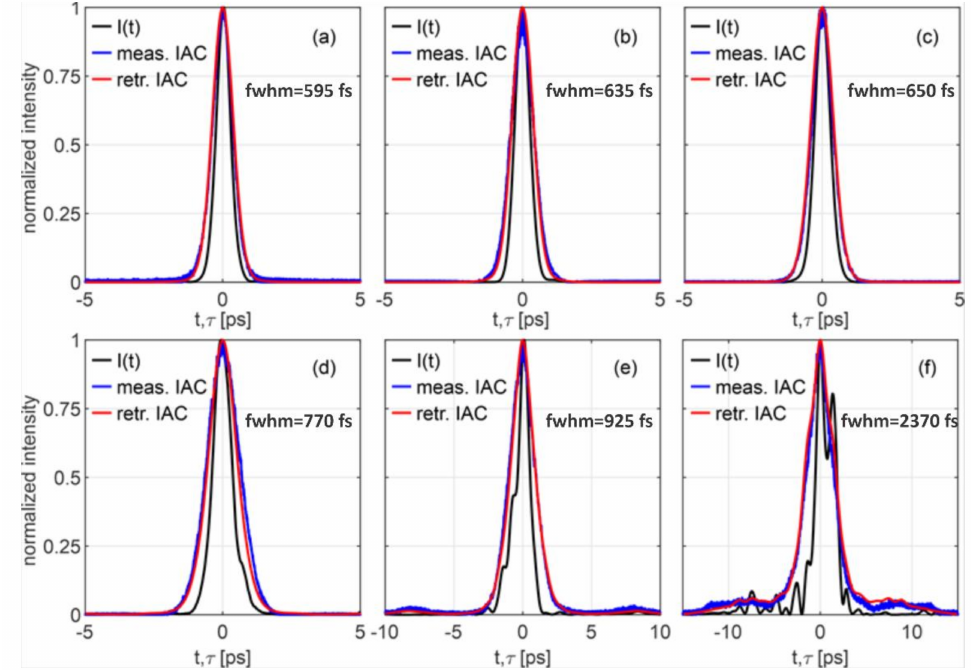
Figure 2. The figure shows temporal pulse shape variations for pulses with 50 µ J energy for different pulse repetition rates. The repetition rates are ( b ) 100 kHz, ( c ) 500 kHz, ( d ) 1 MHz, ( e ) 1.5 MHz and ( f ) 2 MHz. The reference pulse temporal shape at low-pulse energy of 1 µ J and 30 MHz pulse repeti- tion rate is also shown in ( a ). On each subfigure a retrieved pulse intensity from FROG is presented (black) along with retrieved autocorrelation (red) and independently measured autocorrelation